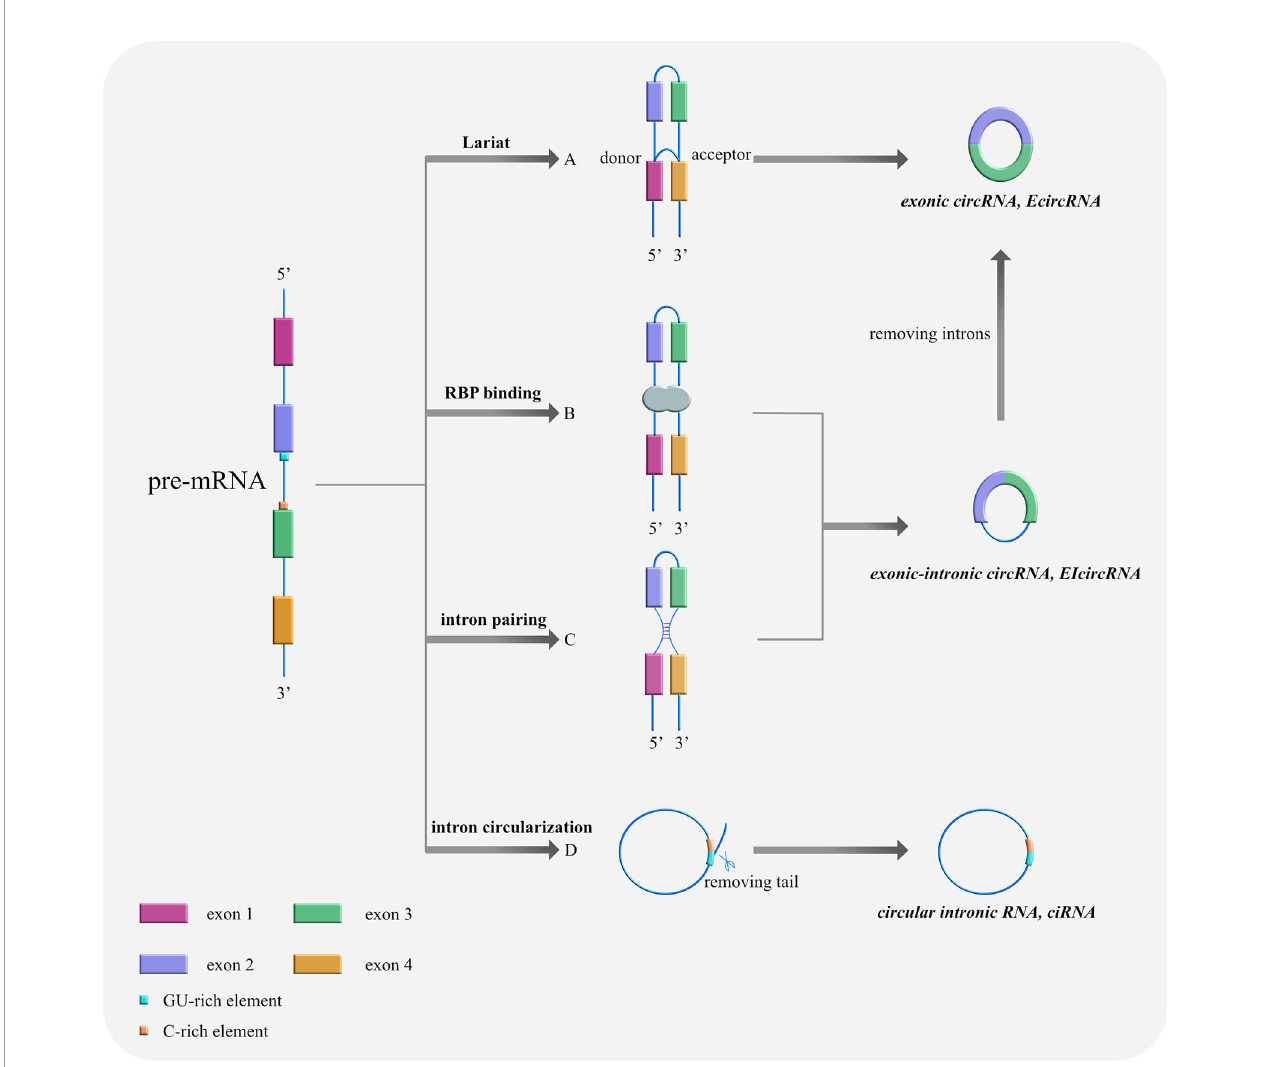
FIGURE 1 | Cyclization models of circRNAs. (A) Lariat-driven cyclization. The 5 ′ donor splice site downstream of exon 4 is connected with the 3 ′ receptor splice site upstream of exon 1, forming a reverse covalently linked lariat structure. Then, the lasso containing skipped exons shears further and removes the introns, thus forming ecircRNA. (B) RNA-binding protein (RBP)-driven cyclization. RBPs bind to the splicing sites of both sides of exons 2 and 3 to assist cyclization and form ElciRNA. (C) Cyclization driven by intron pairing: complementary sequences at the fl anks of exons 2 and 3 bring splicing sites together by base pairing, forming double-stranded RNA side by side. Afterwards, ecircRNA containing exons or EIciRNA containing exons and introns are produced through variable shearing. (D) Self-cyclization of introns: Pre-mRNA is spliced by spliceosome to remove intervening introns and there are only exons left, which are connected to form mature RNA. With the 7nt GU-rich sequence at both ends of the intron, the U-rich sequence, and the 11nt C-rich sequence, an exon-free lariat RNA structure is formed by 2 ′ ,5 ′ connection ’ s